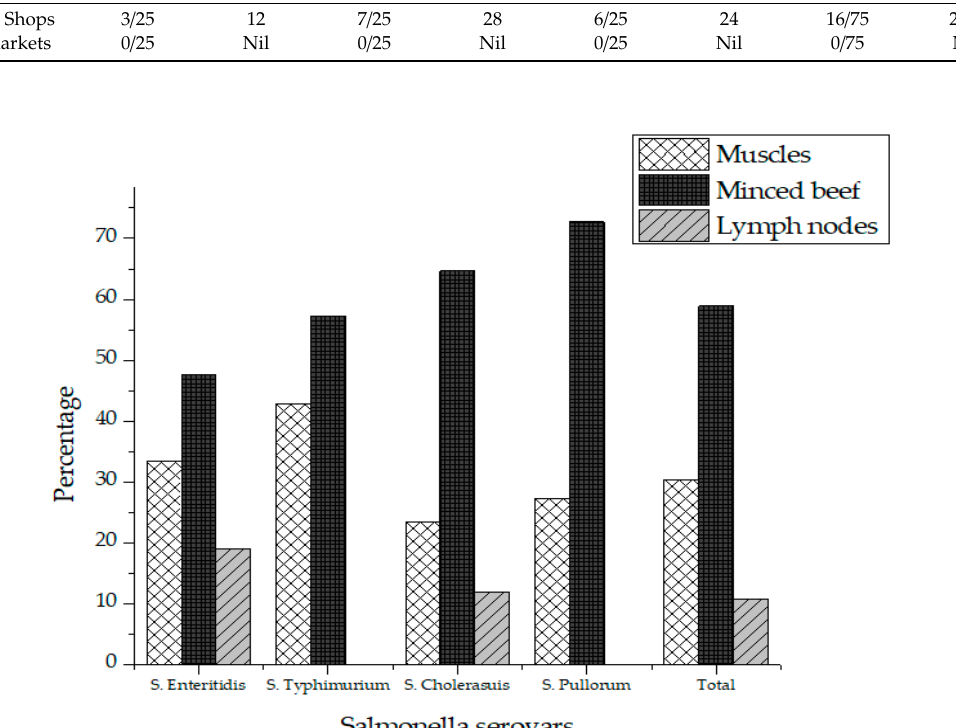
Figure 1. Prevalence of Salmonella in total positive samples.